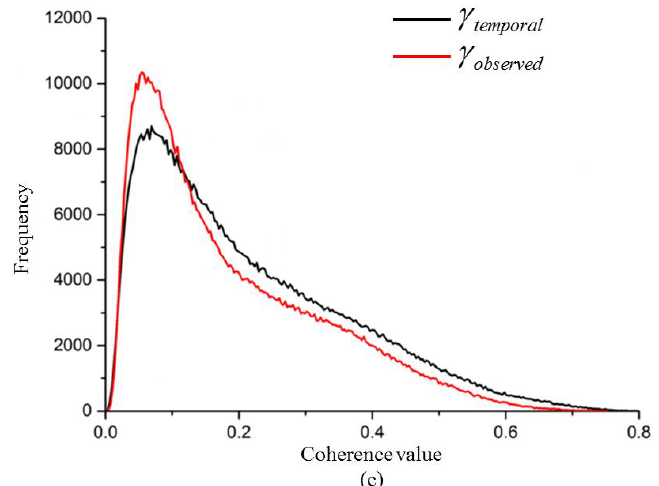
Figure 4. ( a ) The observed coherence data, γ observed of 20080222–20080408 pair; ( b ) the temporal-coherence component, γ temporal of the pair; and ( c ) histograms of (a) and